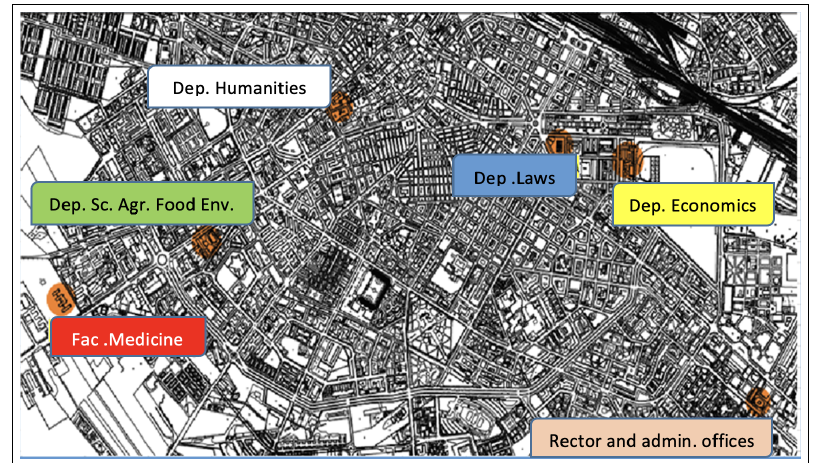
Figure 1. Arrangement of the departments in Foggia.